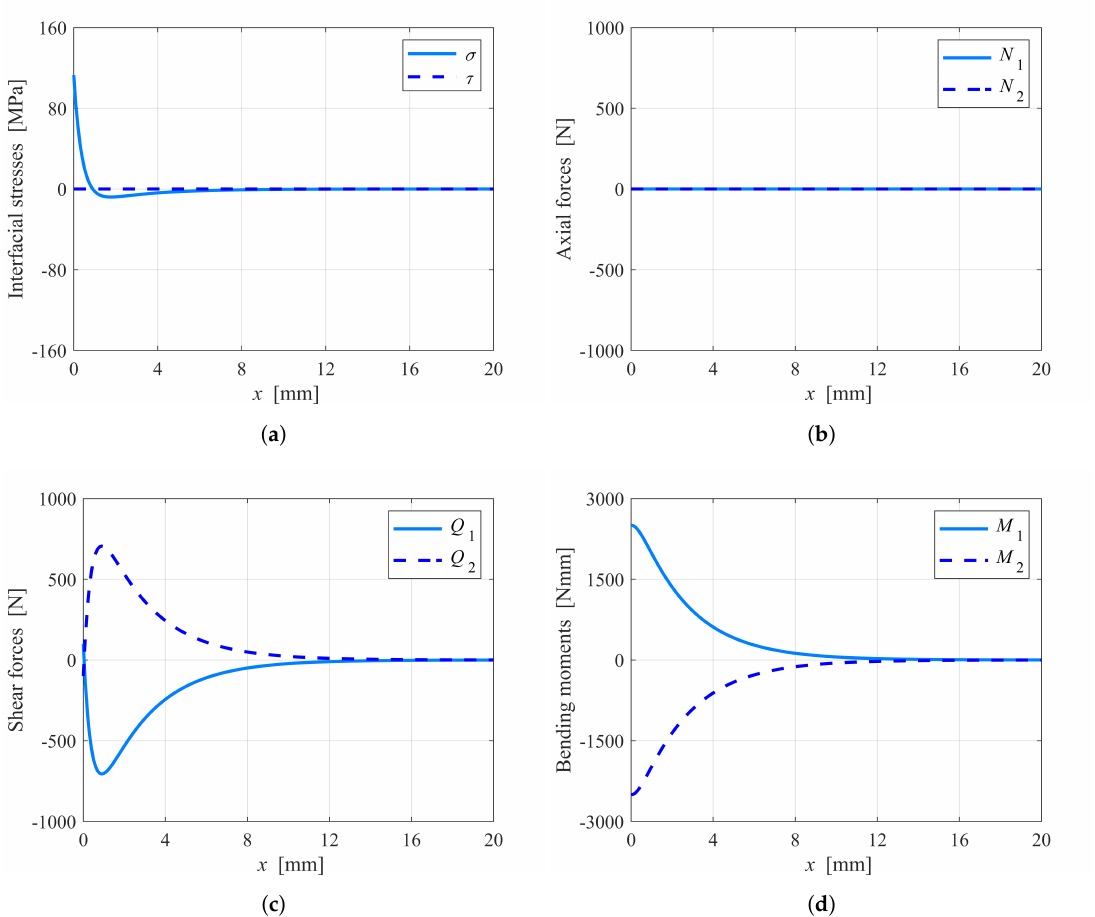
Figure 4. UD//UD specimen: ( a ) interfacial stresses, ( b ) axial forces, ( c ) shear forces, and ( d ) bending moments in the crack tip